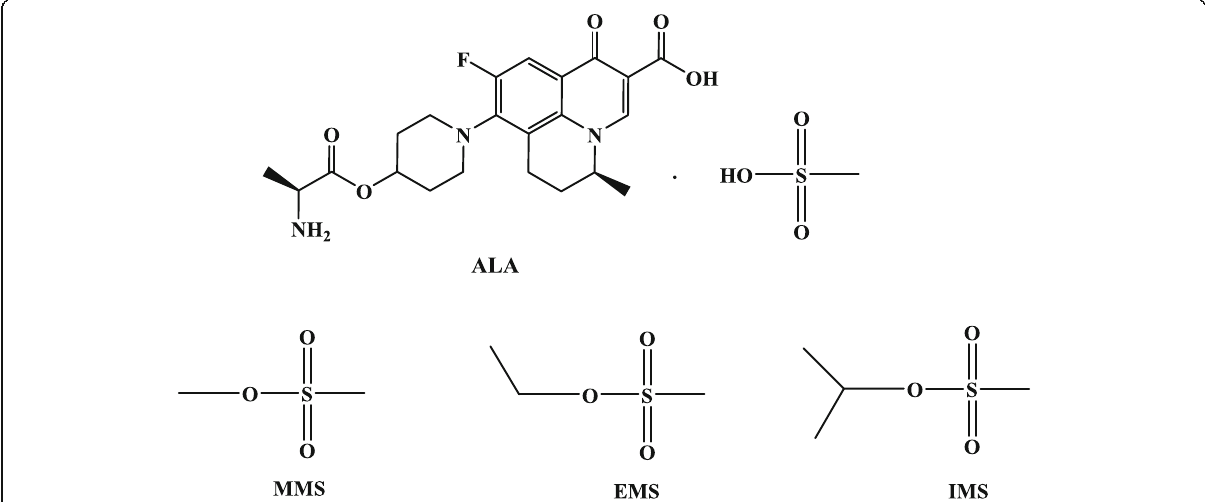
Fig. 1 Chemical structure of ALA (alalevonadifloxacin mesylate), MMS (methyl methane sulfonate), EMS (ethyl methane sulfonate), and IMS (isopropyl methane